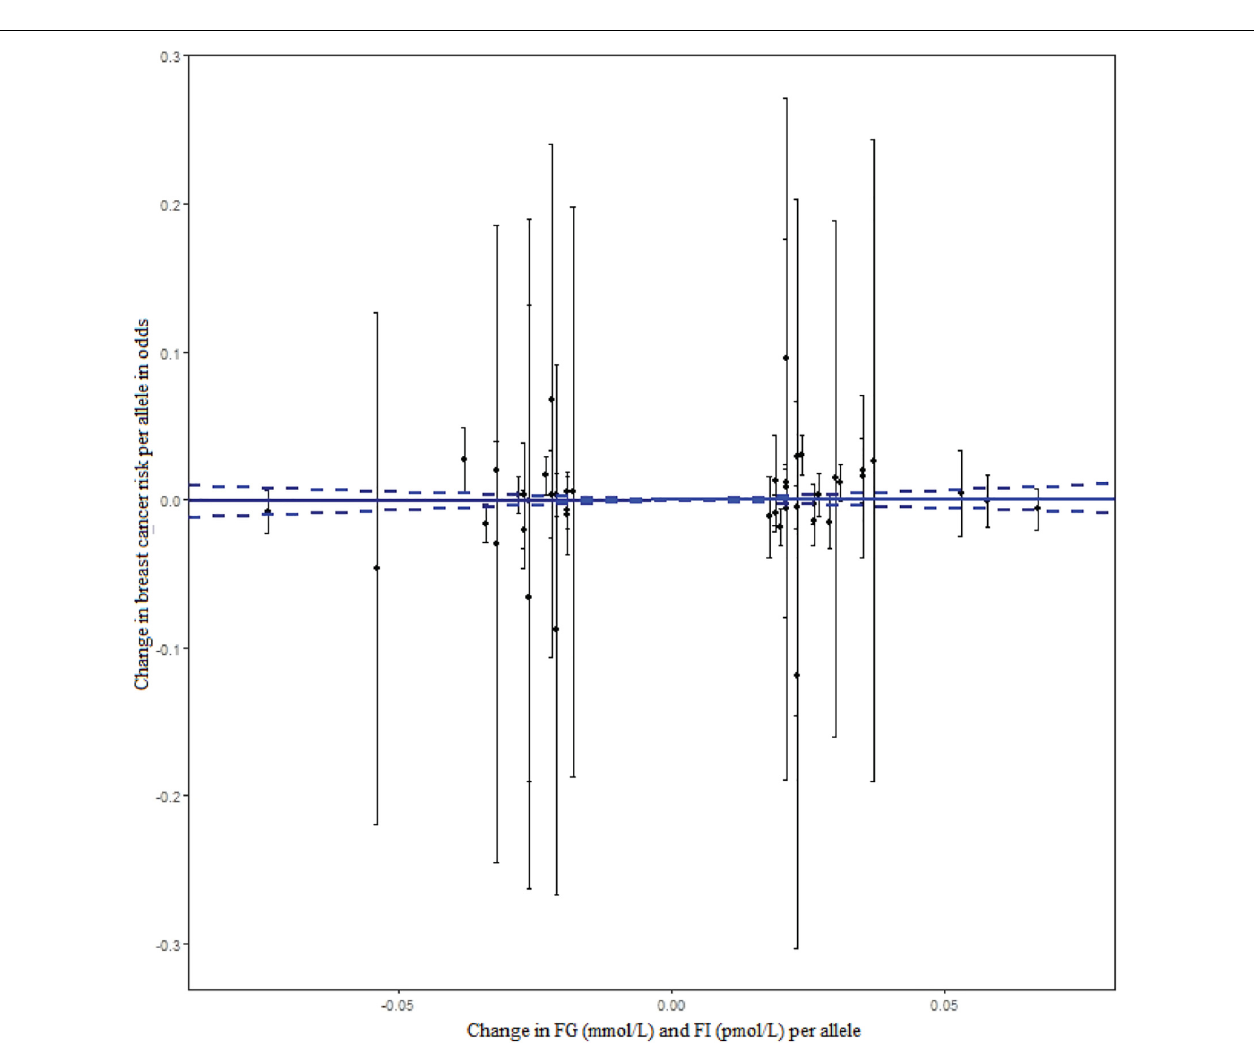
FIGURE 1 | The effect of individual genetic instrumental variables for GTs on breast cancer risk. Each black dot represents a genome-wide GT-associated genetic variant. The blue lines indicate regression and 95% CIs of GTs on breast cancer risk (OR = 1.014, 95% CI: 0.895–1.147). CI, confidence interval; FG, fasting glucose; FI, fasting insulin; OR, odds ratio; GTs, glycemic